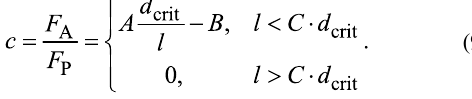
achievable force of adhesion (value at the plateau) decreases and finally vanishes completely (Figure